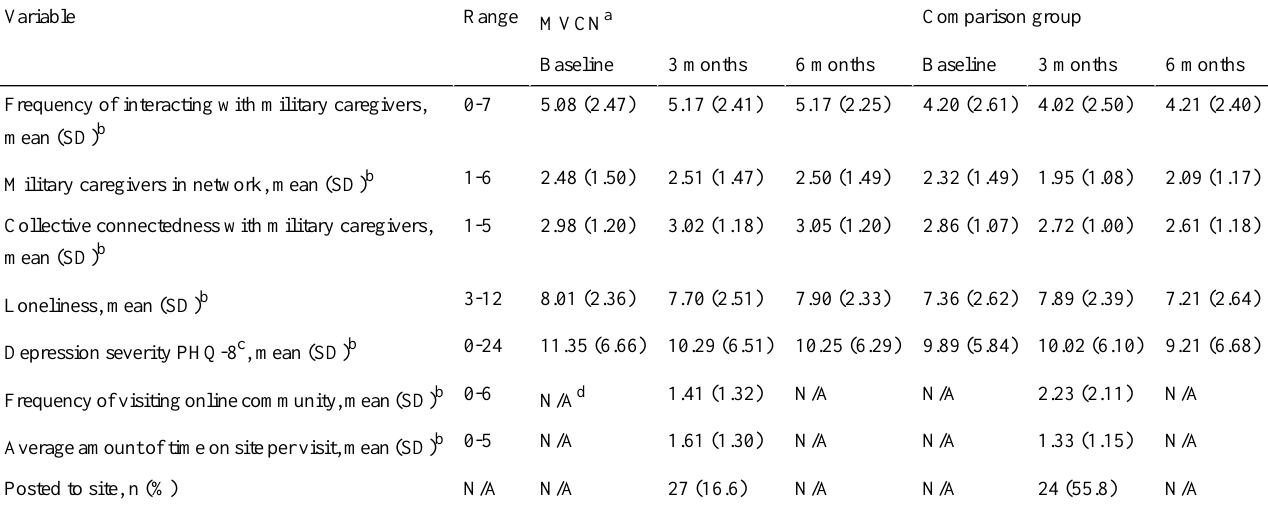
Table 1. Means and SDs for outcome and engagement variables by